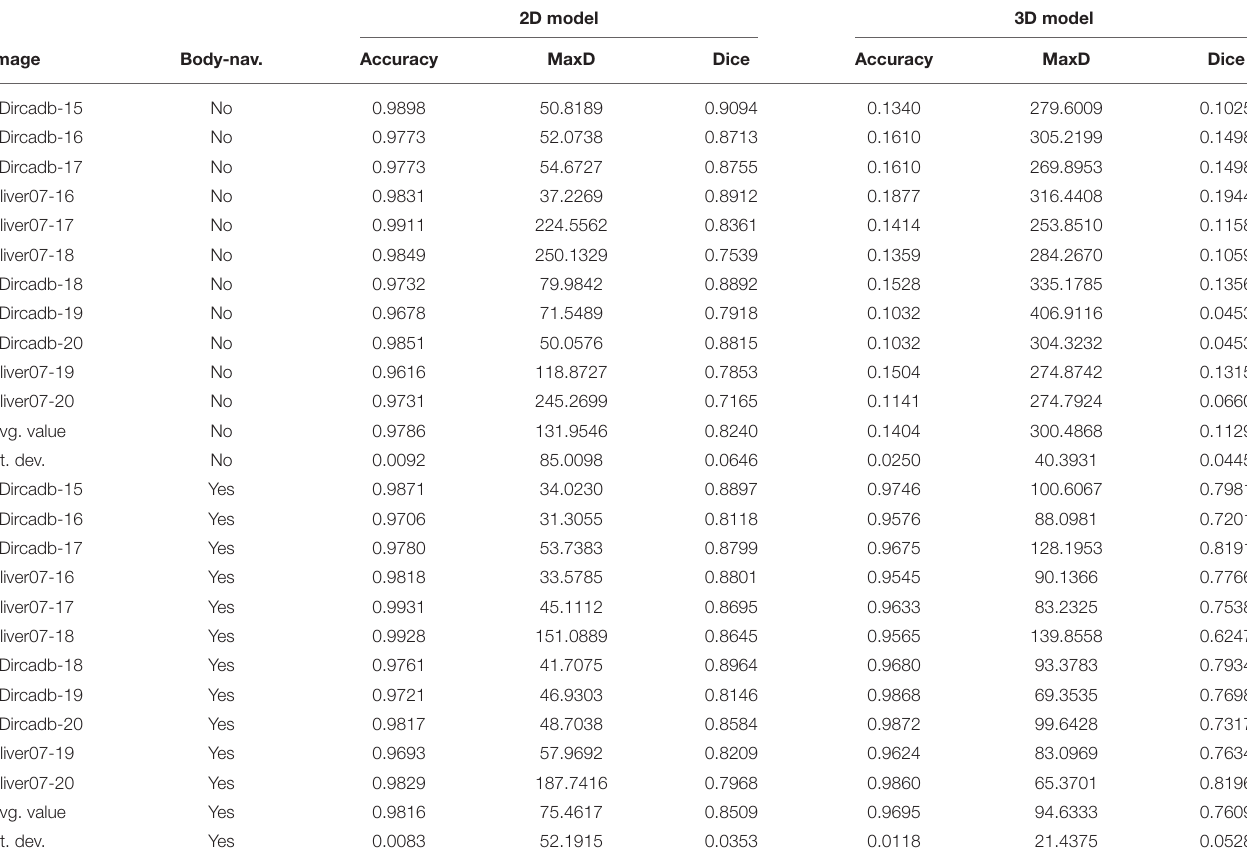
TABLE 1 | Segmentation methods comparison on validation and test